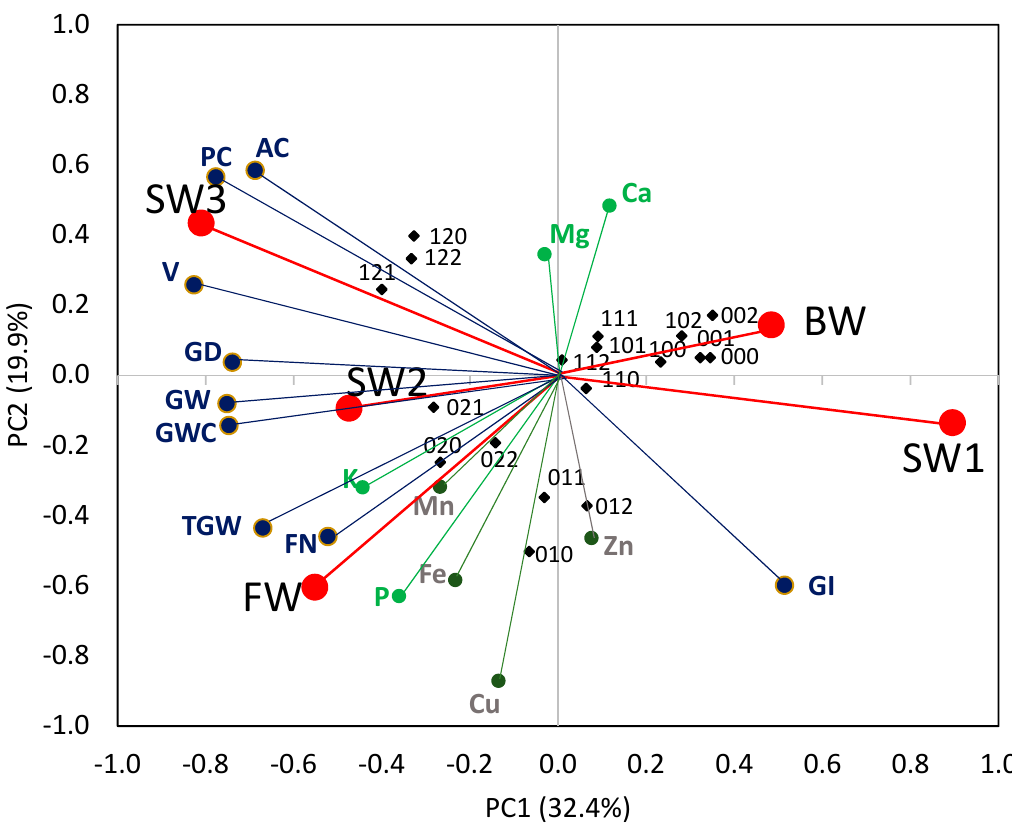
Figure 4. PCA biplot of 9 grain quality parameters (blue lines: TGW, V, PC, AC, GI, GW, GD, and GWC), 4 macronutrients (green lines: P, K, Mg, and Ca), 4 micronutrients (brown lines: Cu, Fe, Mn, and Zn), and 5 milling weight components (red lines: BW, FW, SW1, SW2, and SW3) assessed